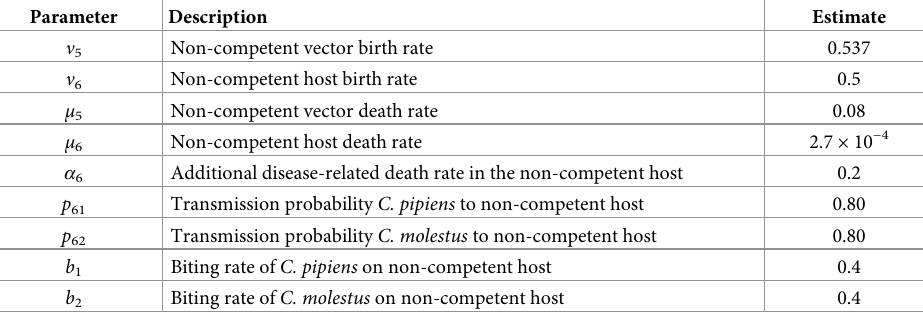
Table 2. Additional parameters regarding simulations with non-competent